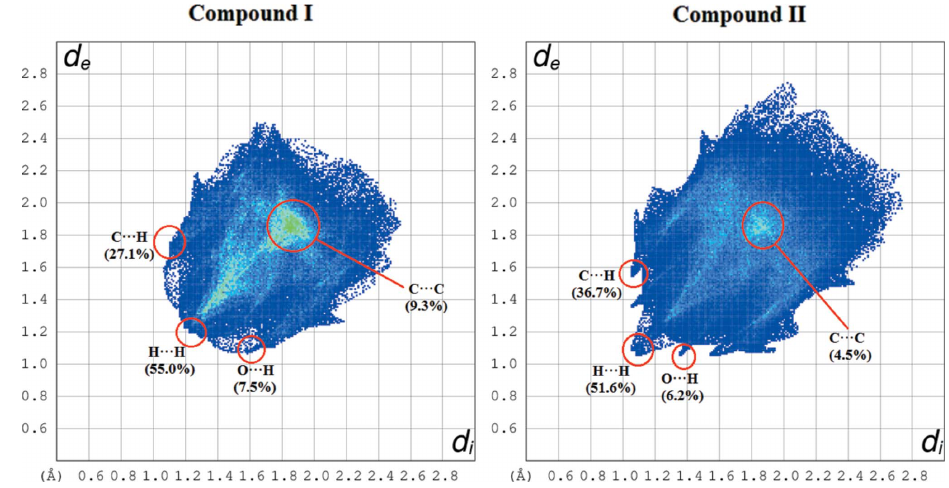
Figure 6 Fingerprint plots of the H (cid:2)(cid:2)(cid:2) H, H (cid:2)(cid:2)(cid:2) O, C (cid:2)(cid:2)(cid:2) H and C (cid:2)(cid:2)(cid:2) C interactions showing the relative contributions to the total Hirshfeld